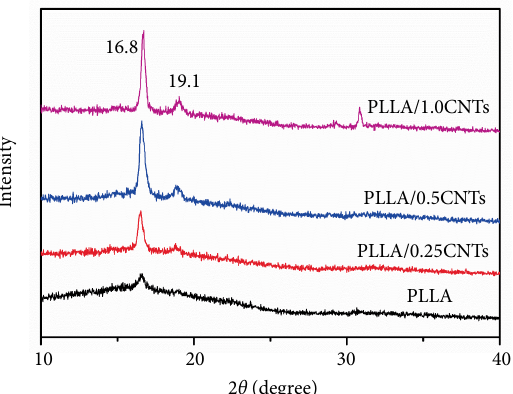
Figure 5: XRD patterns of CNTs, PLLA and PLLA/CNTs composite